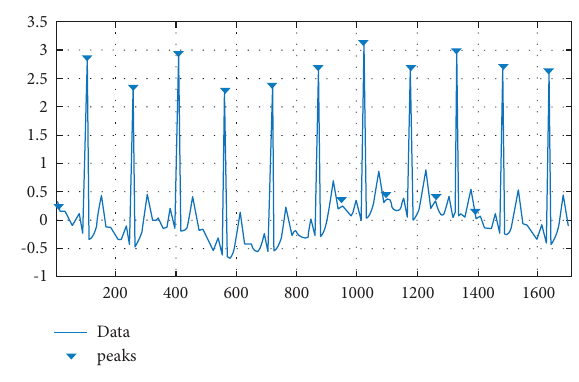
Figure 6: Mark R